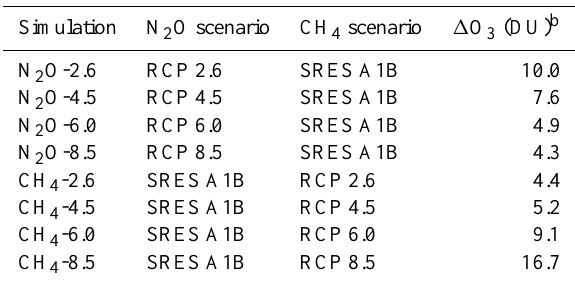
Table 1. Summary of scenarios for the CCM simulations a . Simulation